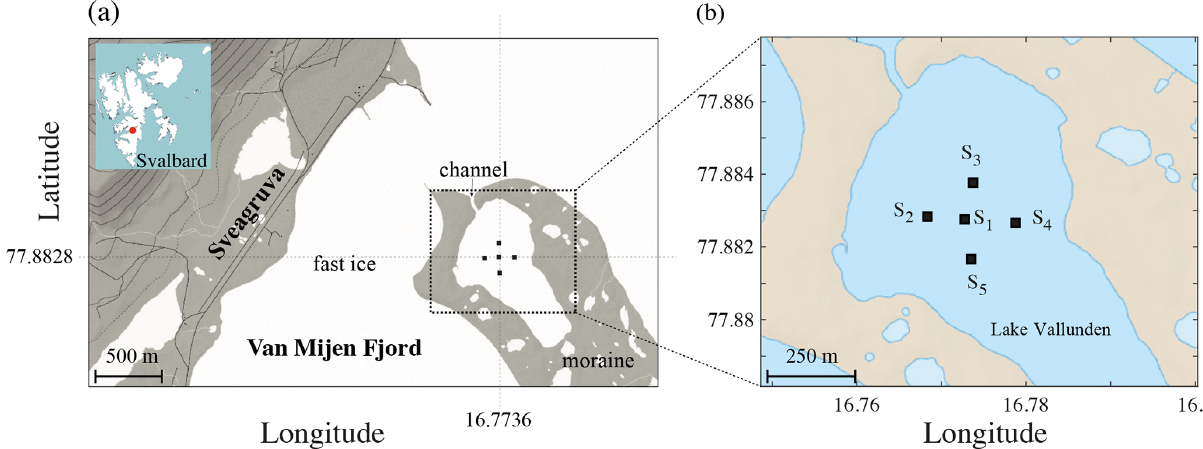
Figure 1. (a) Map of the area where the seismic array was installed (black squares) on Lake Vallunden, Svalbard. It is naturally bounded by moraines and connected to the Van Mijen Fjord by a small channel. The facilities of Sveagruva are located about 1.5km west of the deployment. (b) Zoom on the five seismic stations ( S i , where i = 1, 2, ..., 5) used to record the ambient seismic field. Arrows indicate the positions of ice drillings (ID). ID1 was performed on 1 March, giving a thickness of 62cm; ID2 and ID3 were performed on 26 March, giving thicknesses of 70 and